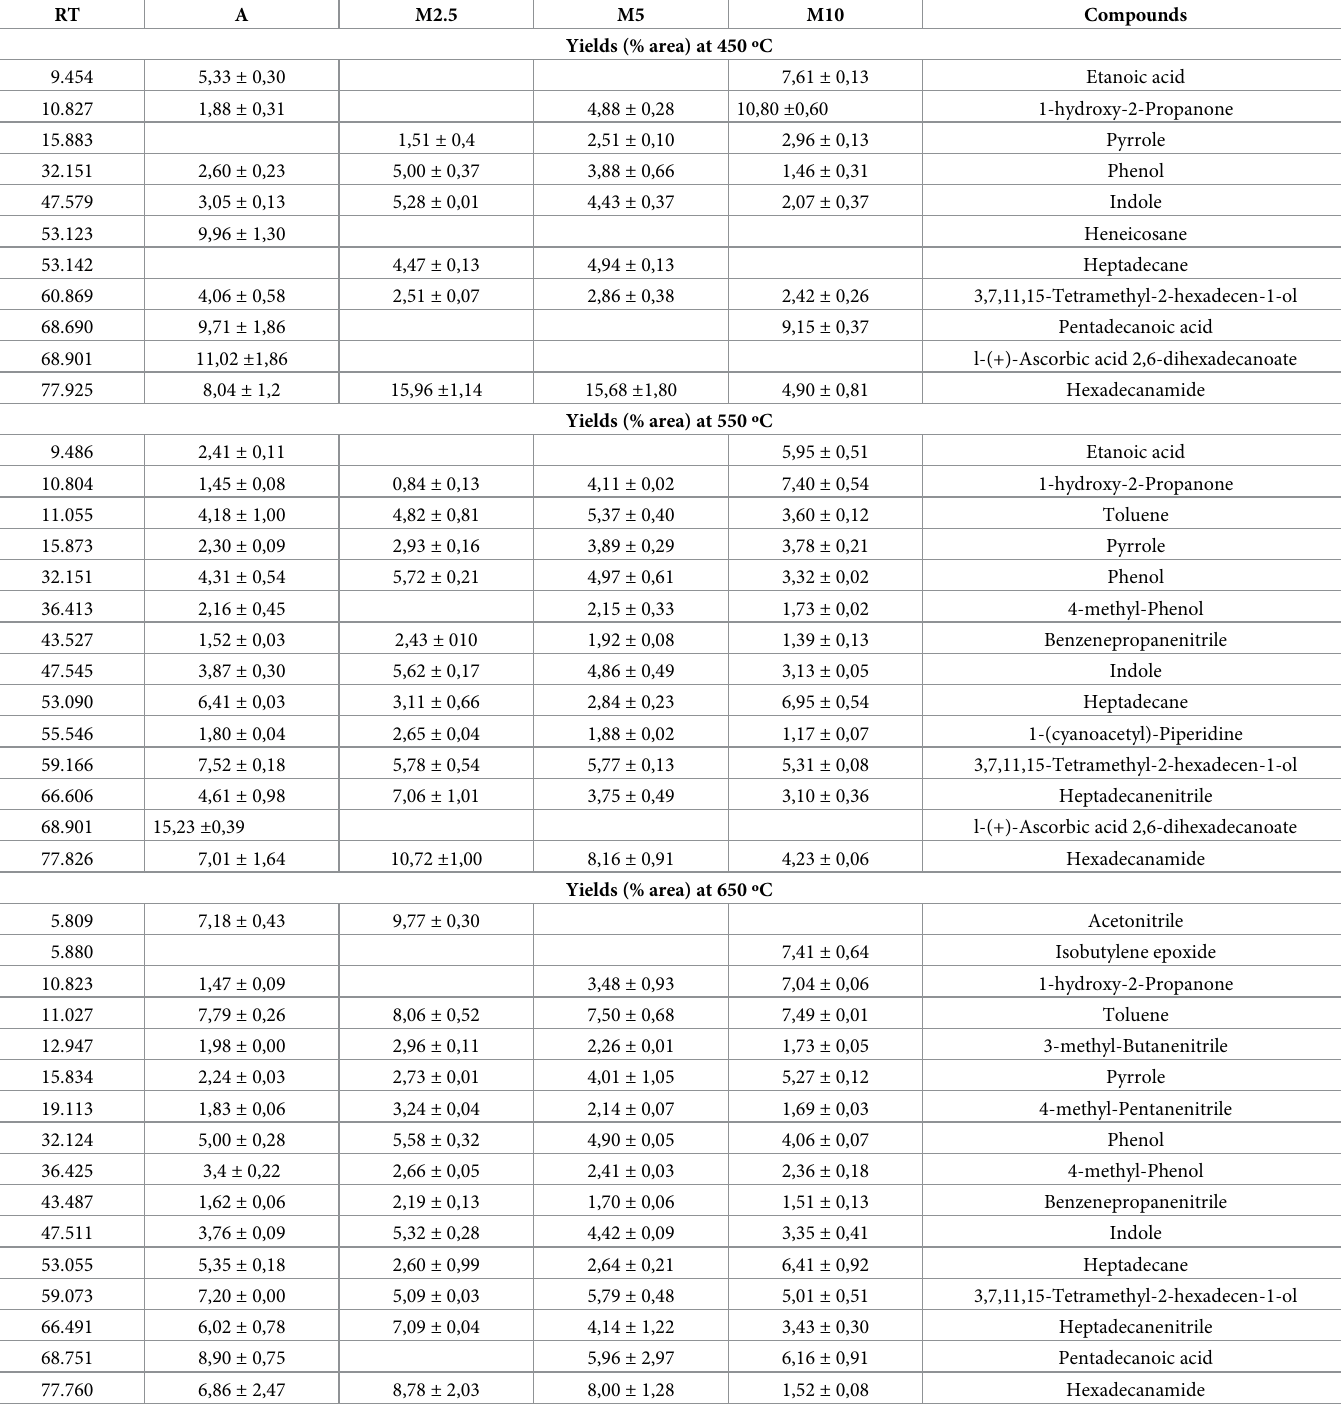
Table 4. List of the main semi-quantified compounds (% area) from pyrolysis of A, M2.5, M5, M10 at 450 º C, 550 º and 650 º